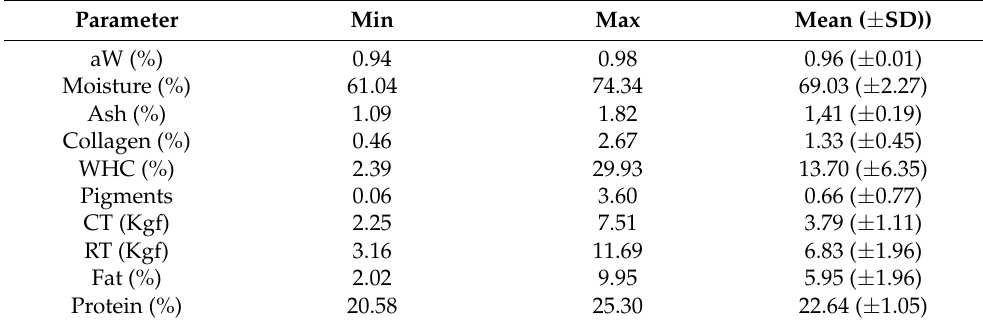
Table 1. Dependent variables result from 40 samples of LTL muscle.